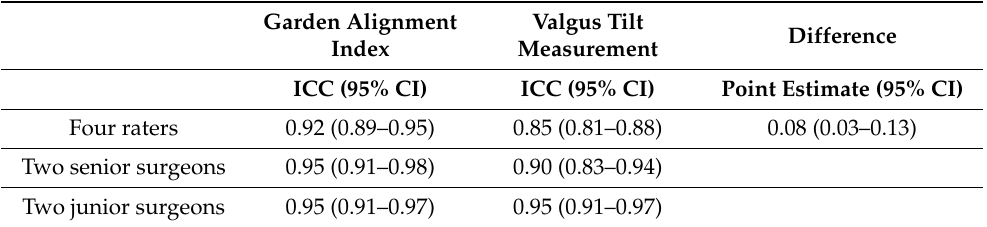
Table 2. Inter-rater reliability of the Garden alignment index and valgus tilt measurement for four raters in 50 hip radiographs.